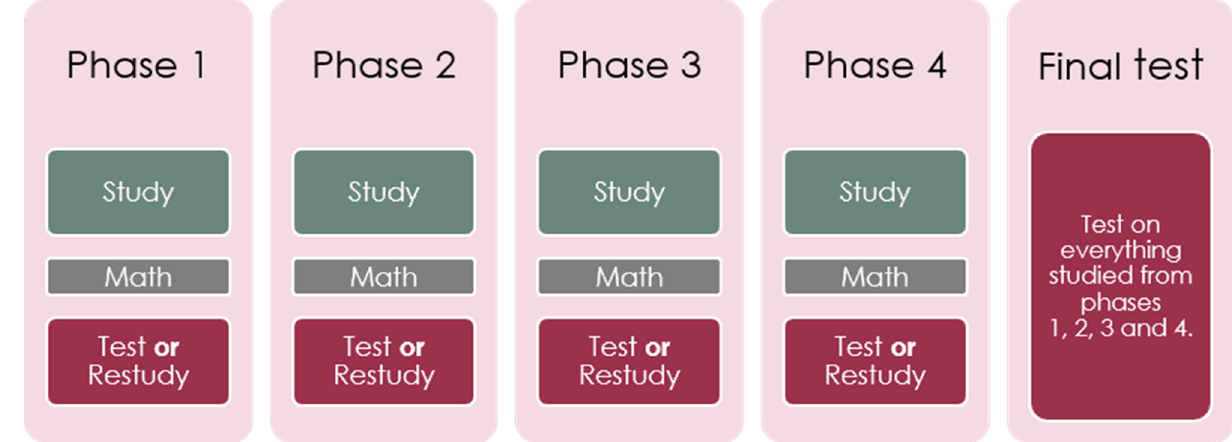
Figure 2. Simplifying diagram which supplemented the information page.